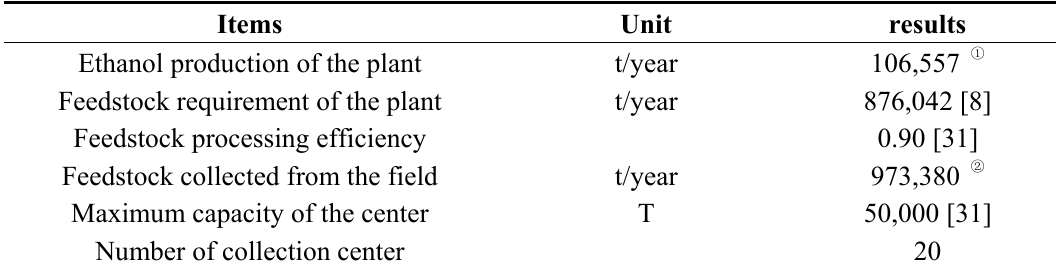
Table 7. General data in feedstock cost estimation.